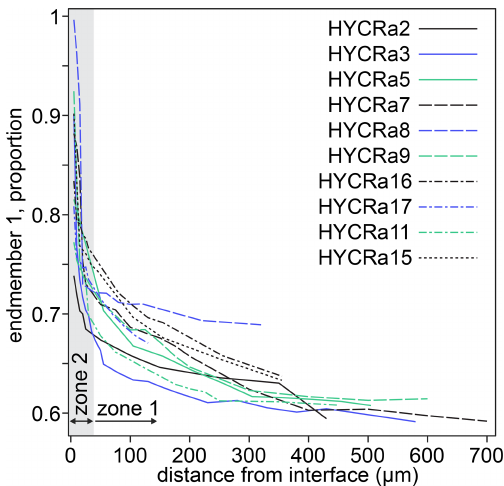
Figure 10. The proportion of end-member 1 as a function of dis- tance from the interface for all crystals studied. The designation of zones 1 and 2 is approximate (30µm from the interface) and based on the break in slope observed in almost all profiles. Further infor- mation regarding the change in behaviour between zones 1 and 2 is given in Fig. S9. The relative uncertainties (2 σ ) from linear com- bination fitting are generally 0.2%–1.5%. These are given in the